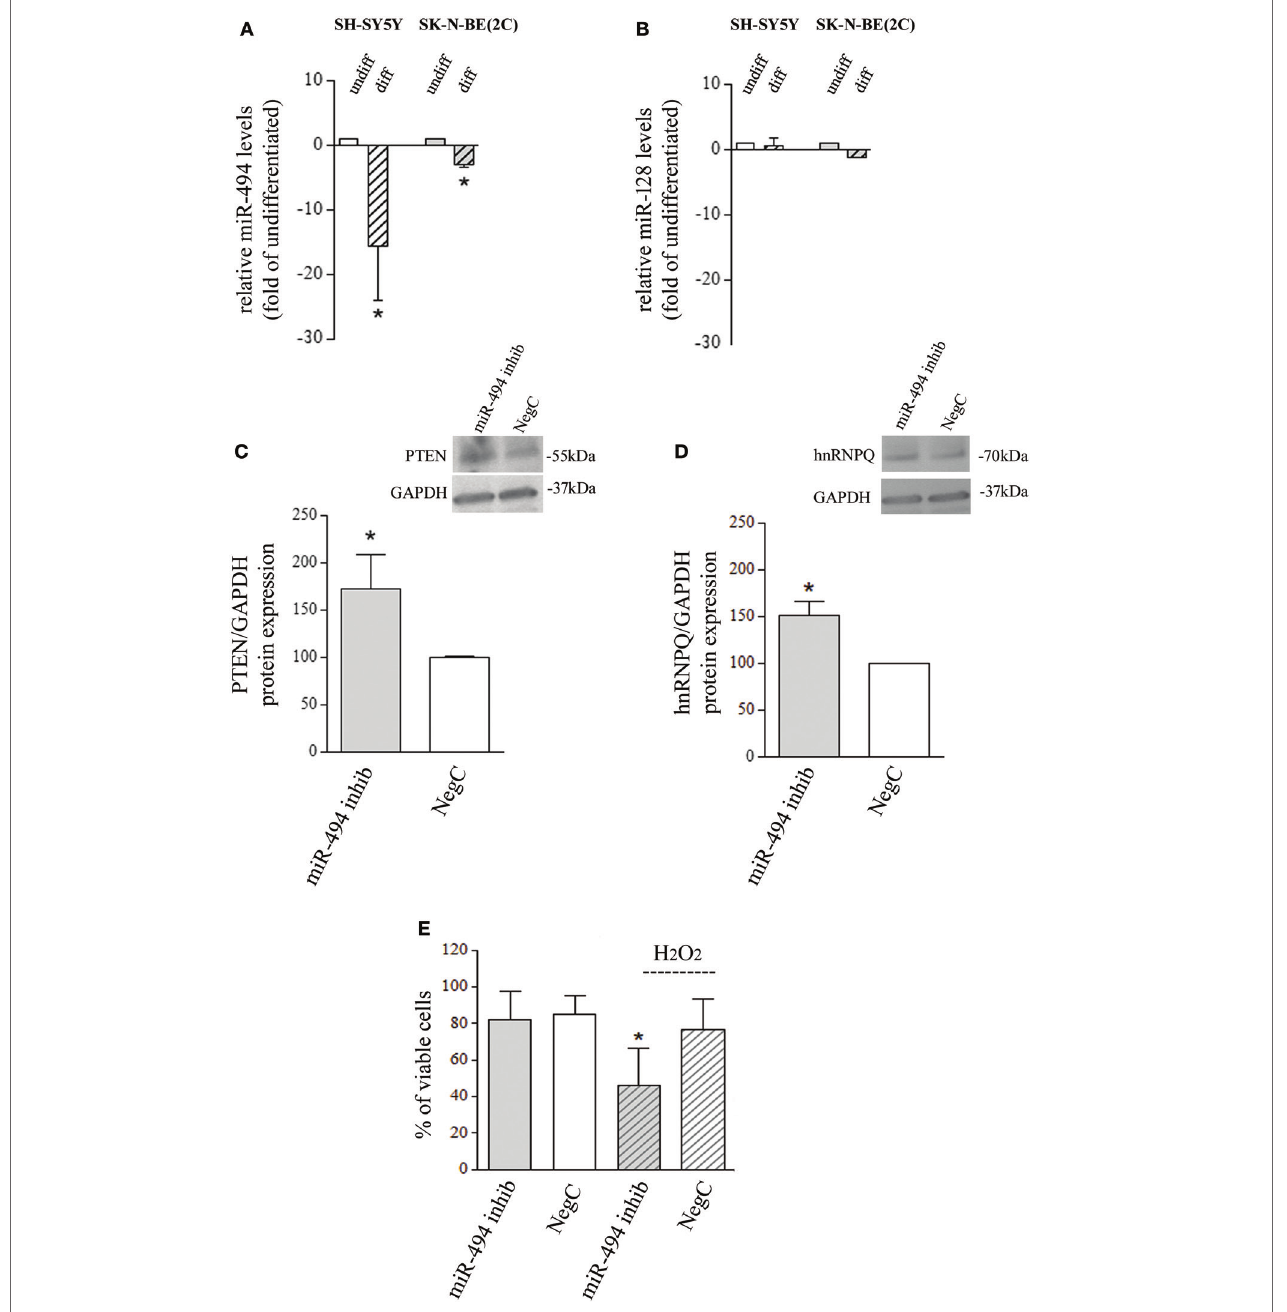
figUre 1 | miR-494 downregulation occurs in neuroblastoma (NB) differentiation and modify cell response to H 2 O 2 . (a) Expression levels of mature miR-494 in undifferentiated or all-trans retinoic acid (ATRA)-differentiated SH-SY5Y and SK-N-BE(2C) NB cells. hsa-miR-425-5p and hsa-let7g-5p were used as endogenous reference miRs. Results are reported as relative to the values obtained in untreated control cells, which was set equal to 1. Statistical analysis: n = 3; * p < 0.05 vs undifferentiated. (B) Expression levels of mature miR-128 in undifferentiated or ATRA-differentiated SH-SY5Y and SK-N-BE(2C) NB cells. hsa-miR-425-5p and hsa-let7g-5p were used as endogenous reference miRs. Results are reported as relative to the values obtained in untreated control cells, which was set equal to 1. Statistical analysis: n = 3. No significant differences. (c) WB analysis of PTEN. GAPDH expression has been used as loading control. 40 µg of protein has been loaded. The bands show the most representative experiment. Statistical analysis: n = 3; * p < 0.05 vs NegC. (D) WB analysis of hnRNPQ. GAPDH expression has been used as loading control. 40 µg of protein has been loaded. The bands show the most representative experiment. Statistical analysis: n = 2; * p < 0.05 vs NegC. (e) Percentage of viable cells (Trypan blue analysis) after miR-494 inhibition and 24 h exposure to 500 µM H 2 O 2 . Statistical analysis: n = 4; * p < 0.05 vs NegC and miRNA 494 inhibitor.